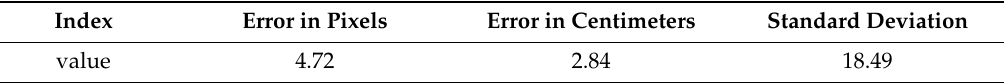
Table 3. Results of the dividing points extraction.